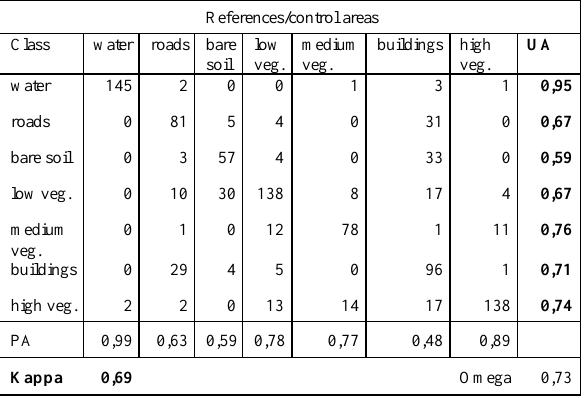
Table 2. Random Forests (100) classification results for “W” area